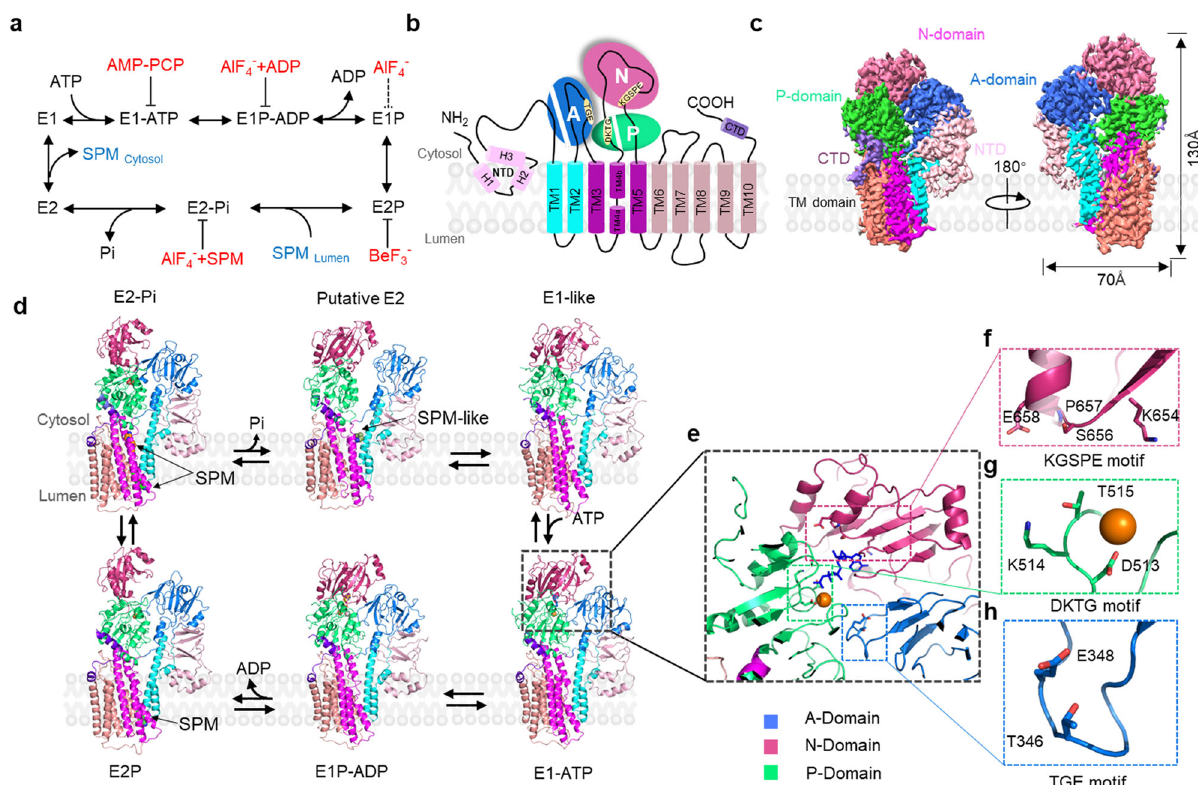
Fig. 1 | Cryo-EManalysis ofhumanATP13A2. a Schematic diagram of Post-Albers cycle for ATP13A2. The transportof SPM is shown inblue. Components that mimic theenzymeintermediatesoftheirrespectivereactioncyclesareshowninred.SPM (marked in blue) is recruited from the lumen side of ATP13A2 in the E2P state and released into the cytoplasm in the E2 state. b Topology diagram of hATP13A2. ConserveddomainsandTMhelicesareschematicallyillustrated.Inthecytoplasmic regions, the A, N, and P domains and the C-terminal regulatory domain (CTD) are colored marine, pale violet red, limegreen, and medium purple, respectively. TM1- TM2, TM3-TM5, and TM6-TM10 of ATP13A2 are cyan, magenta, and salmon. The speci fi c N-terminal domain (NTD) is colored in pink. The DKTG motif in the P- domain,theKGSPEmotifintheN-domain,theTGEmotifintheAdomain,andTM4